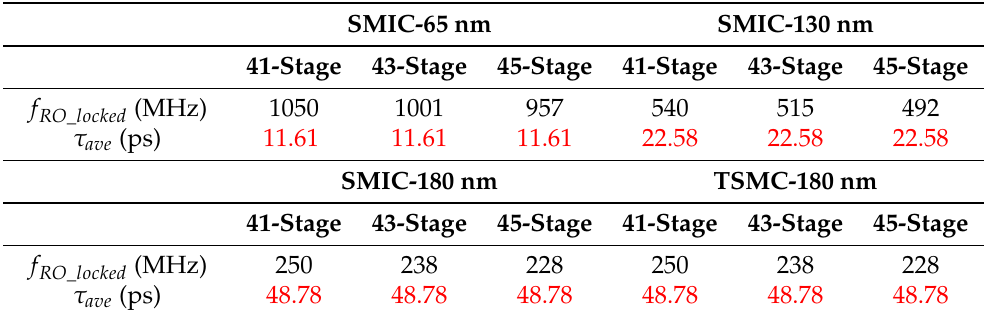
Simulation results of stage-independent locking with different CMOS processes, f RFI = 43,050